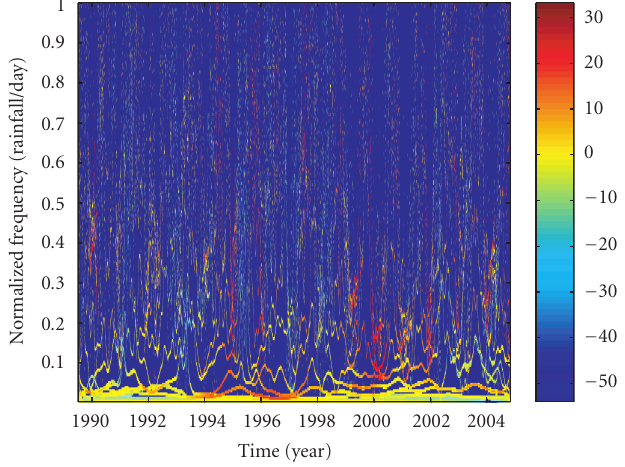
Figure 3.3. Hilbert spectrum of the decomposed rainfall data using 256 frequency bins after 3 × 3 Gaussian filtering. The amplitude is in